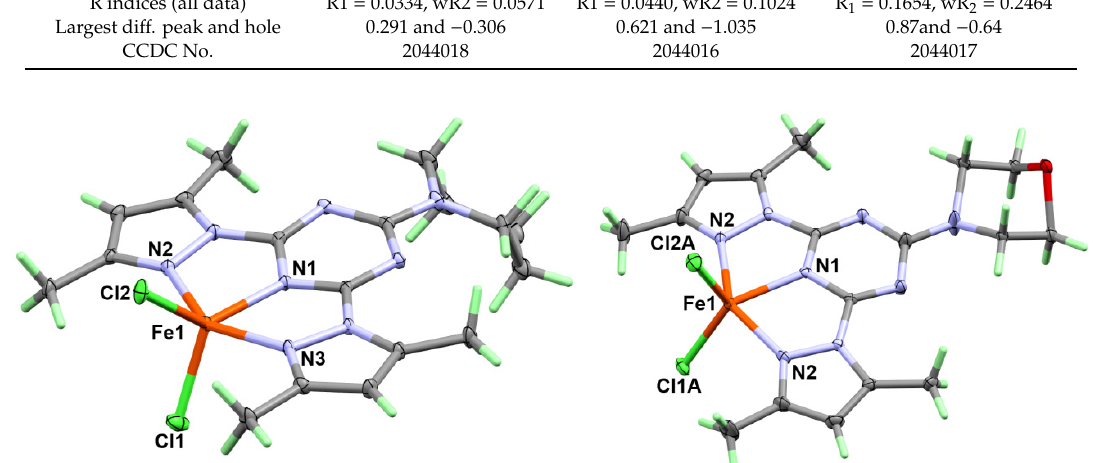
Figure 2. X-ray structure of complexes 1 (left) and 2 (right), the atoms have been drawn at a 30% probability level. The [FeCl 4 ] - anions in the outer sphere were omitted for better clarity. Table 2. Bond distances and angles in 1 .